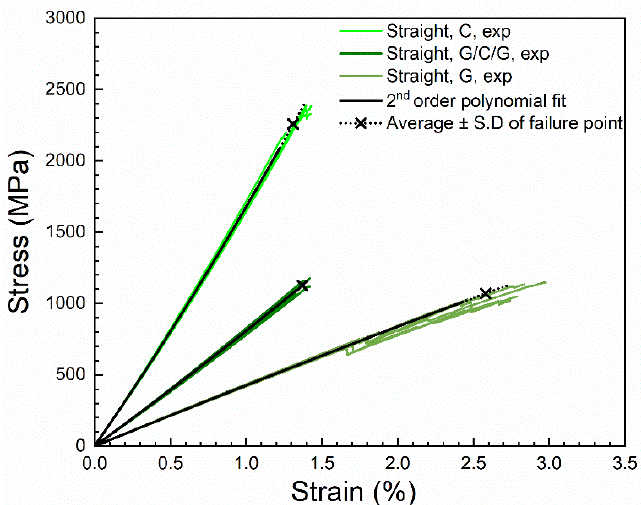
Figure 9. Experimental and second-order polynomial fitted stress–strain curves of straight-sided specimens of unprotected and protected carbon composites, and unprotected glass composites. The single fitted curve for each type of composite represents an average of the individually fitted curves.